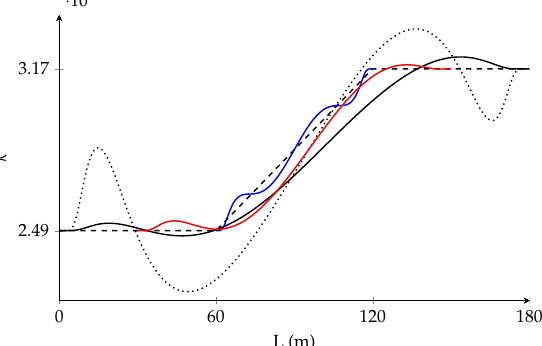
Figure 17. Curvature plots of the clothoid with parts of the circular segments (dashed) and default ERB-function blending splines, with local Bézier curves, for the three entry points [ p 1 , q 1 ] (blue), [ p 2 , q 2 ] (red), and [ p 3 , q 3 ] (black). In addition, the curvature of a blending spline with local arc curves, in [ p 3 , q 3 ] , is plotted (dotted).